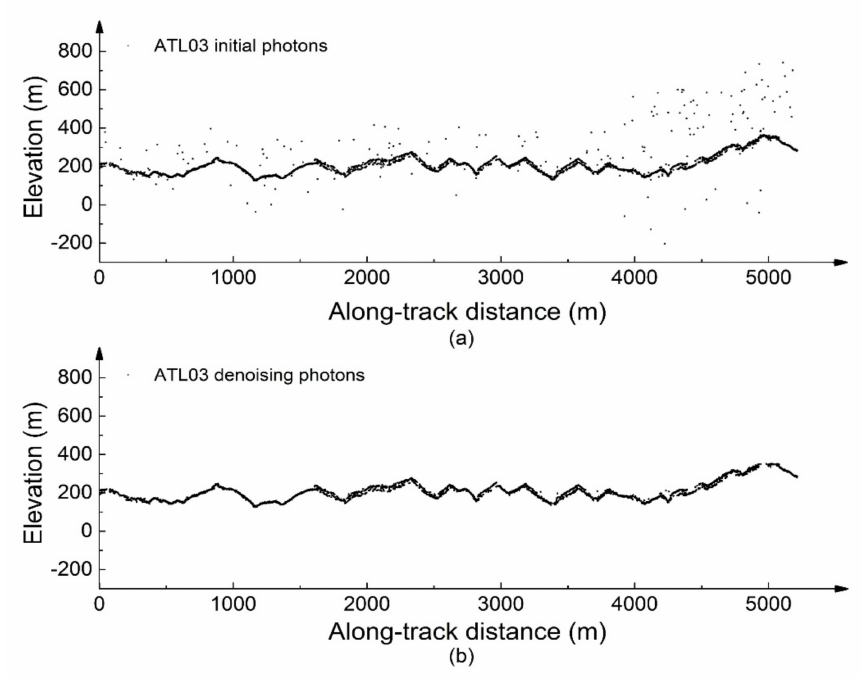
Figure 6. Comparison between ATL03 initial photons and denoised photons: ( a ) ATL03 initial photons; ( b ) ATL03 denoising